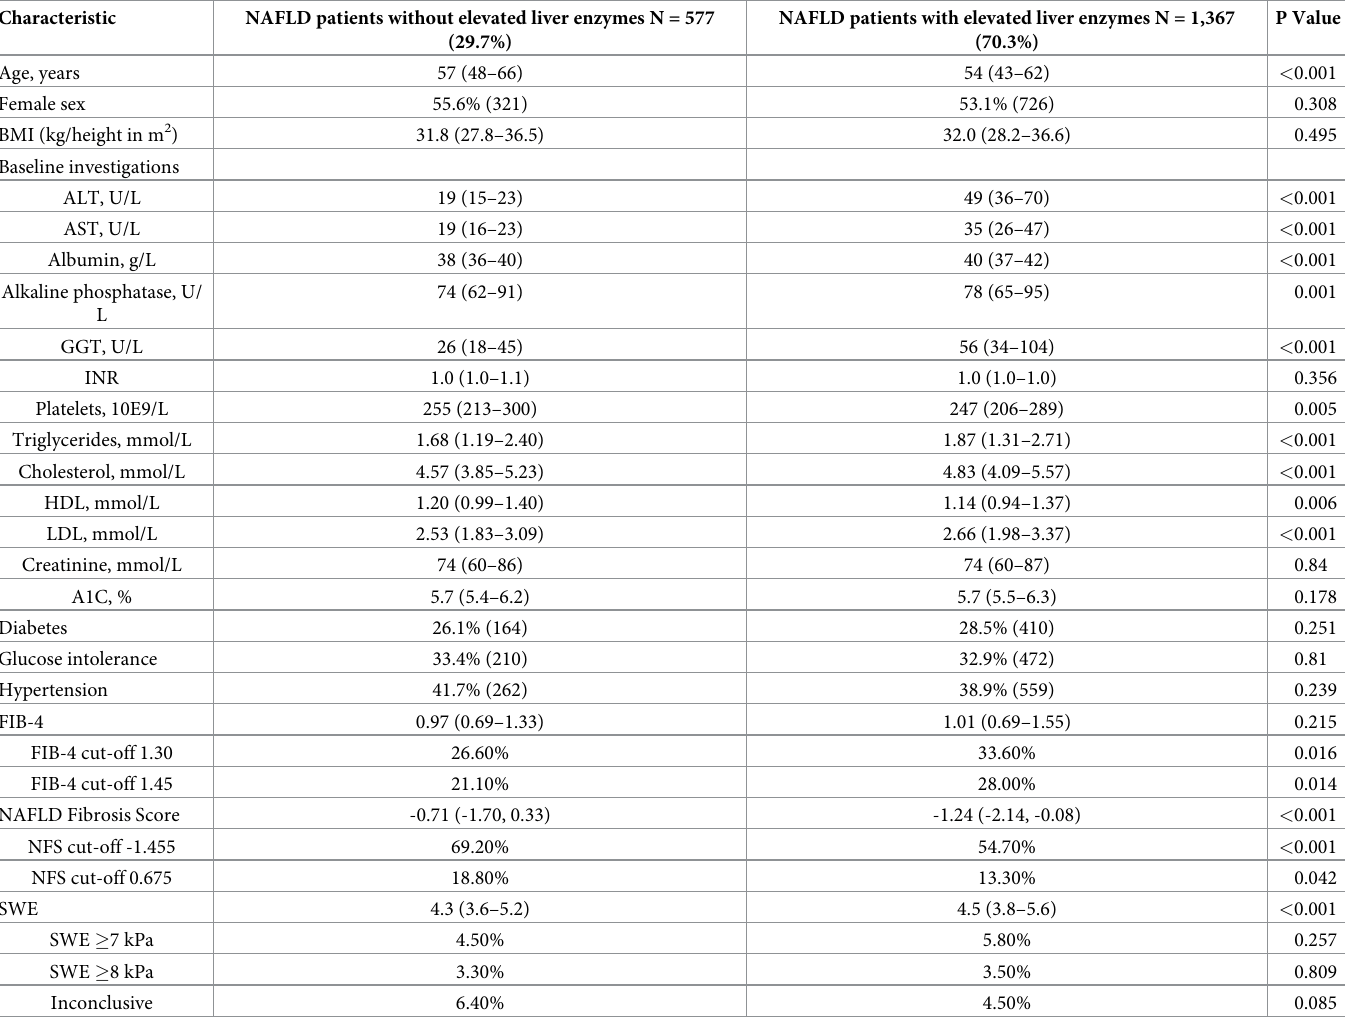
Table 1. Demographic details of NAFLD risk stratification